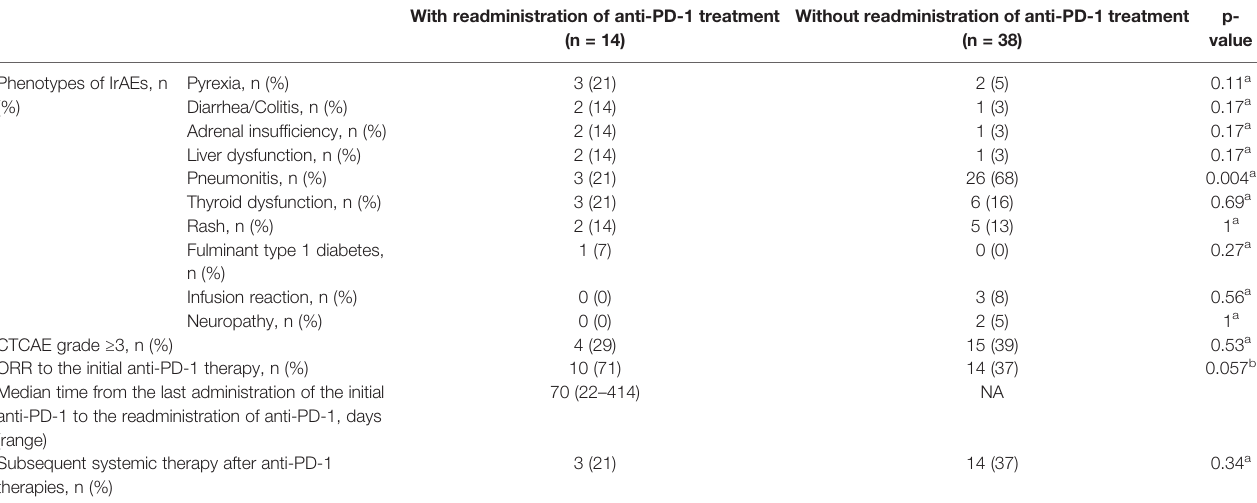
TABLE 5 | Characteristics of the initial irAEs and clinical courses, related readministration of anti-PD-1 treatment.